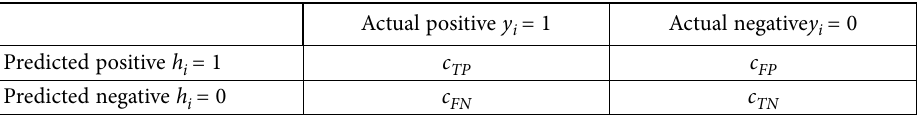
Table 2. Cost matrix